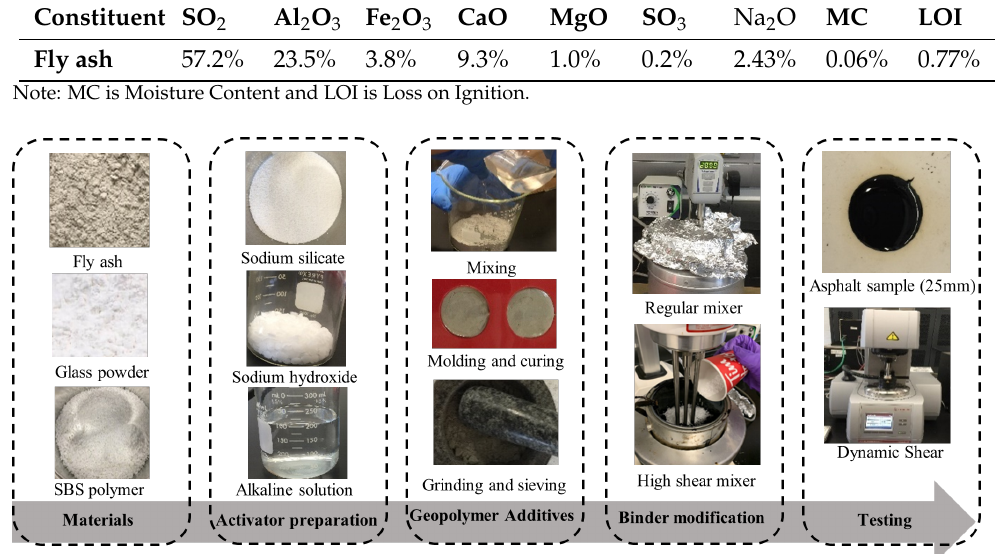
Figure 1. Additive’s preparation and